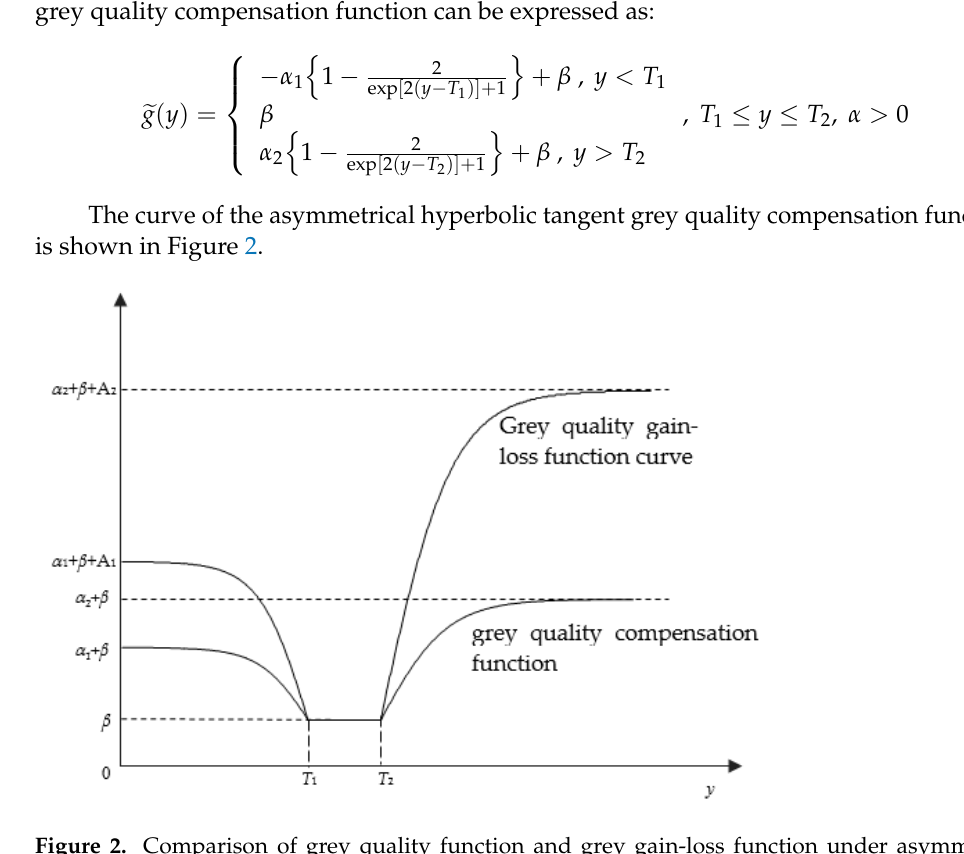
Figure 2. Comparison of grey quality function and grey gain-loss function under asymmetric hyperbolic tangent compensation ( β > 0).